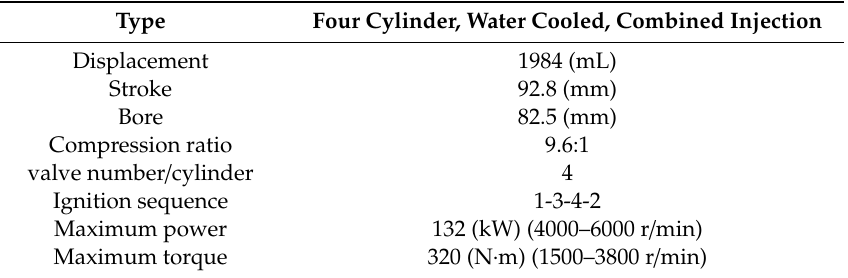
Table 1. Main technical parameters of the